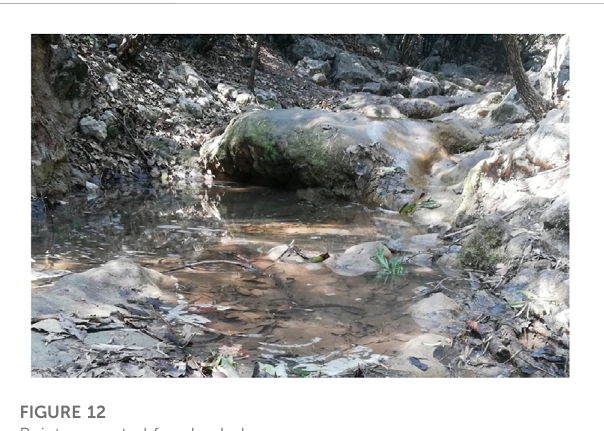
FIGURE 12 Point suggested for check